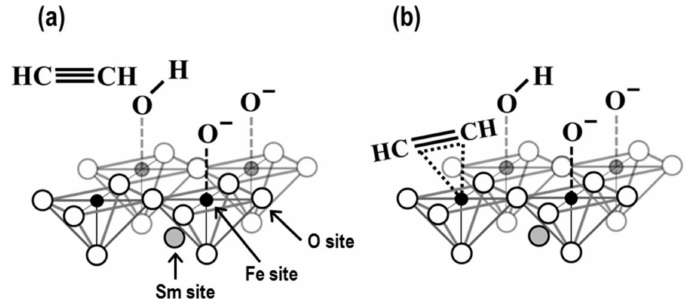
Figure 12. Schematic of the surface of perovskite-type oxide and appearance of adsorbed C 2 H 2 on an active site of perovskite; ( a ) before and ( b ) after